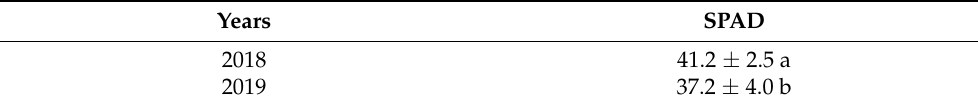
Table 5. Effect of different years on leaf SPAD value of